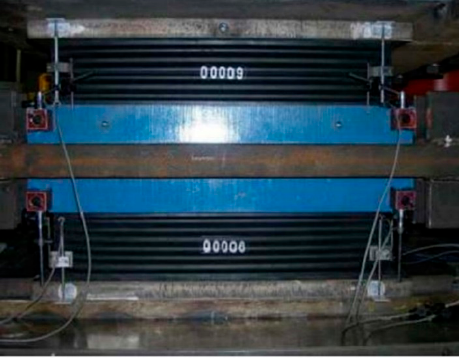
Figure 8. Static compression test assembly [13].